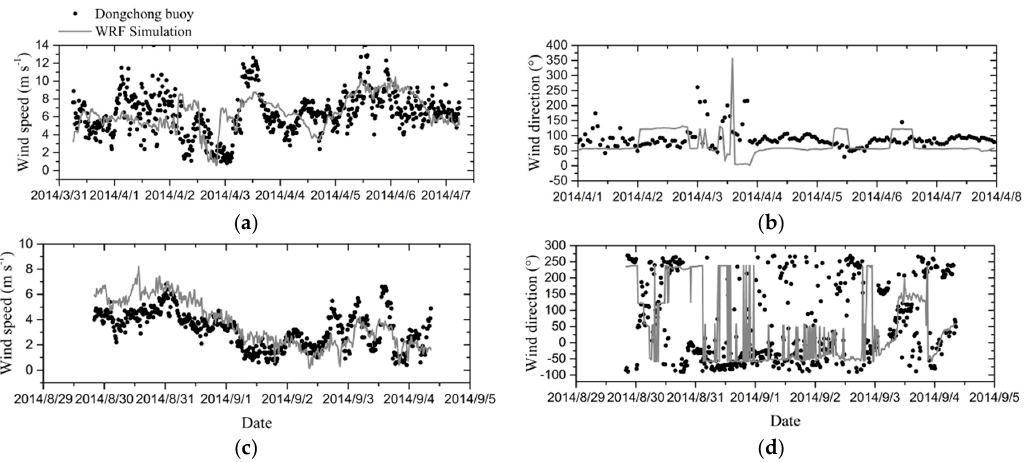
Figure 5. The comparisons between observed and simulated wind speed and direction at 3 m-elevation under normal conditions: ( a ) the wind speed from 1 to 8 April 2014; ( b ) the wind direction from 1 to 8 April 2014; ( c ) the wind speed from 29 August to 5 September 2014; and ( d ) the wind direction from 29 August to 5 September 2014.